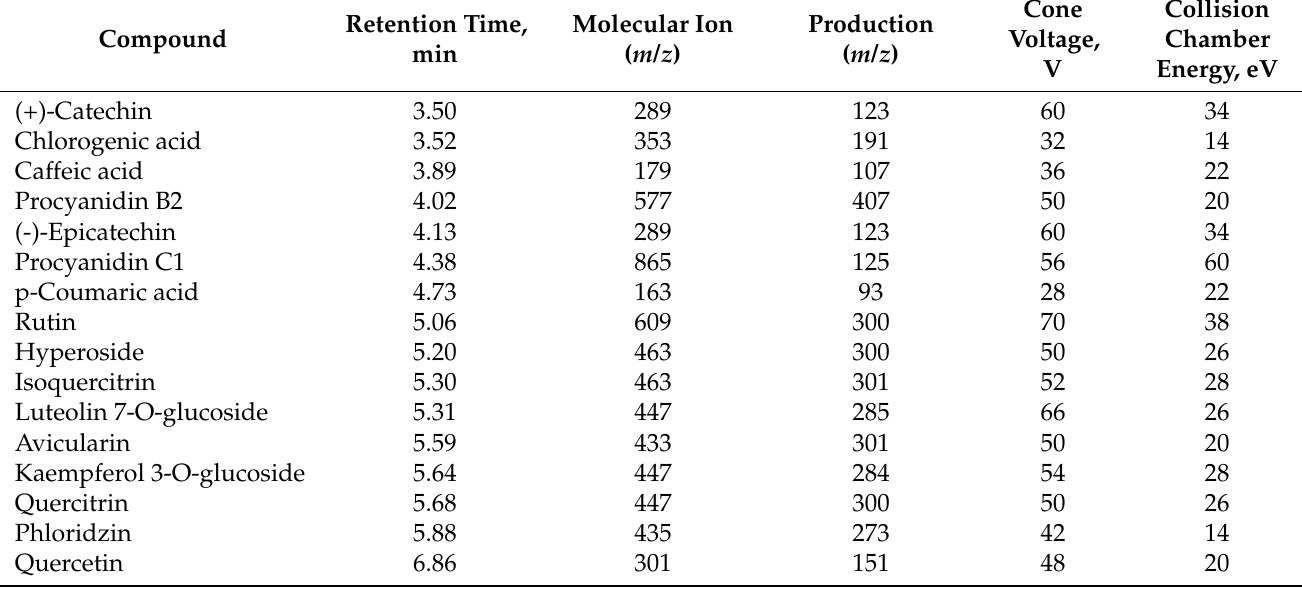
Table 1. Mass spectrometry parameters for the analysis of phenolic